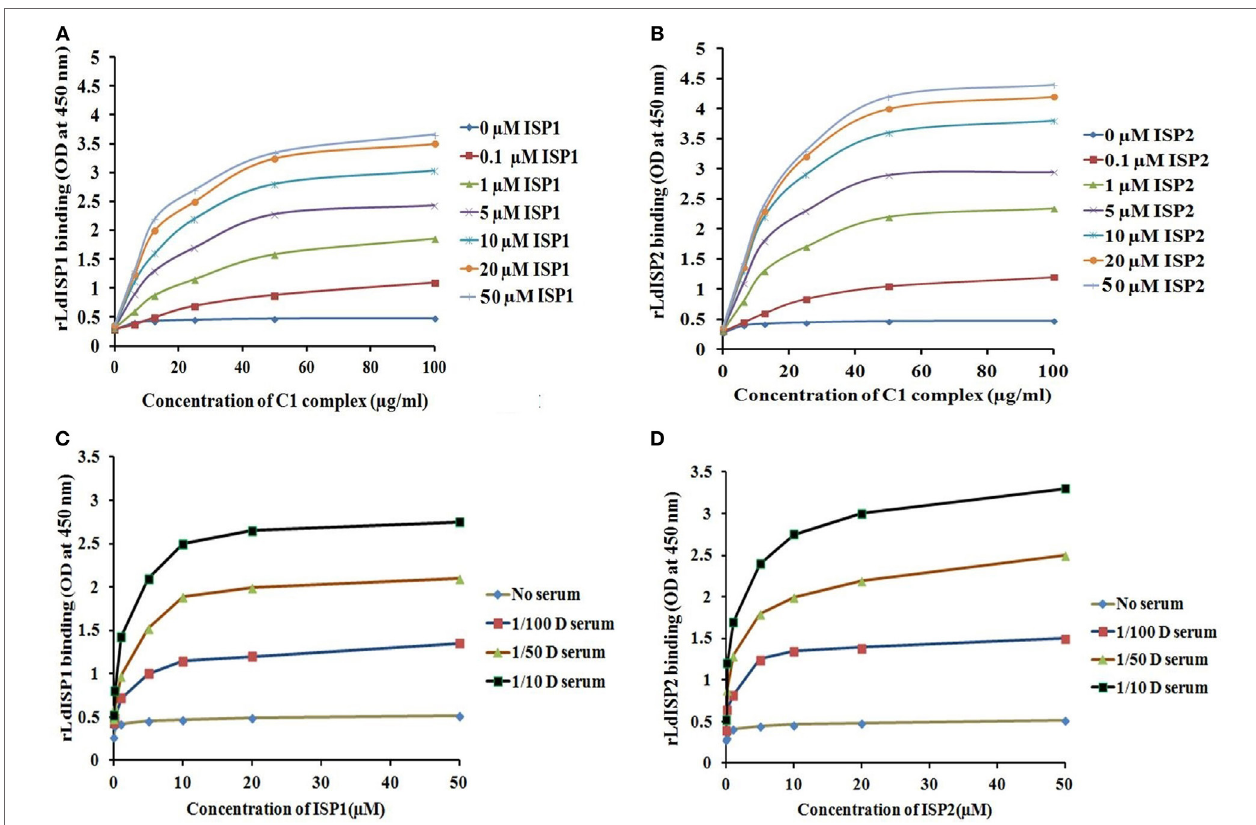
FigUre 2 | In vitro interaction of rLdISP1 and rLdISP2 with C1 complex and MBL-associated serine proteases (MASPs). C1 complex and normal human serum (NHS) were allowed to bound with IgM and mannan-coated plates for interaction study of C1 complex (a,B) and MASPs (c,D) , respectively. Different concentration of C1 complex (0–100 µg/ml) and different dilution of NHS (1:100, 1:50, 1:10) was used for the study. Simultaneously, different concentration of rLdISP1 and rLdISP2 (0–50 µM) was added to the C1 and MASPs bound plate and incubated at 37°C for 2 h. Bound rLdISP1 or rLdISP2 was detected with goat anti-ISP1 antibody and anti-ISP2 antibody, respectively, followed by HRP conjugated rabbit anti-goat IgG-Ab. Optical density was taken at 450 nm in ELISA plate reader. Results are representative of two independent experiments and data showed the mean of duplicate observation.